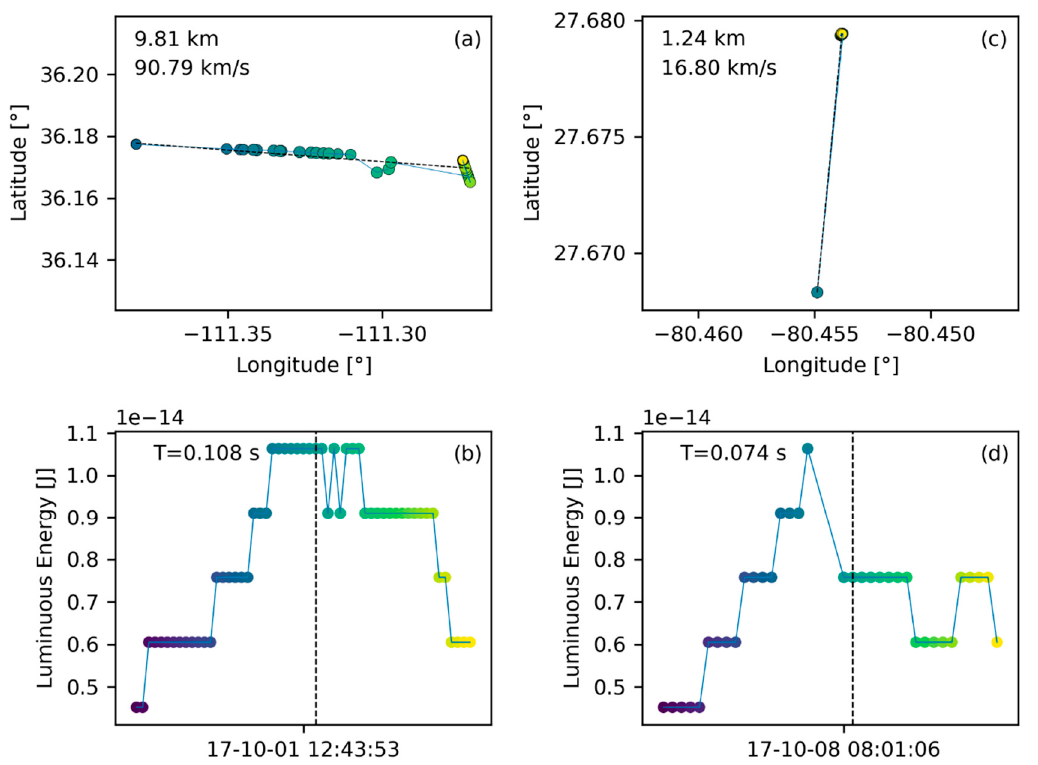
Figure 13. Two small true positive bolide signatures confirmed by All Sky measurements [20]. Groundtrack ( a ) and light curve ( b ) correspond to the same flash. Similarly, ( c ) and ( d ) are one flash.